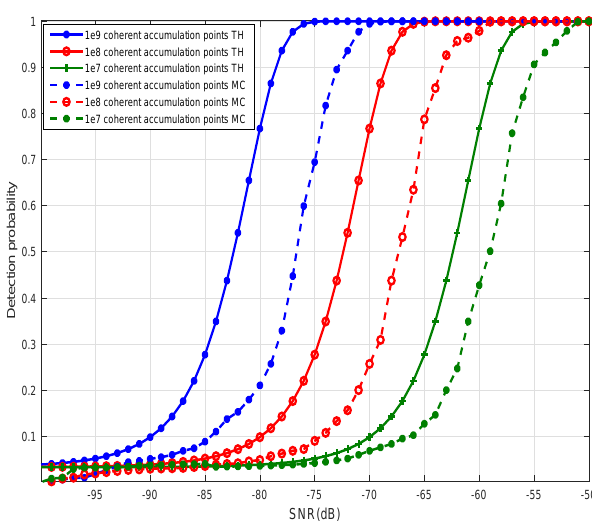
Figure 4. Relationship between coherent accumulation points and detection performance.